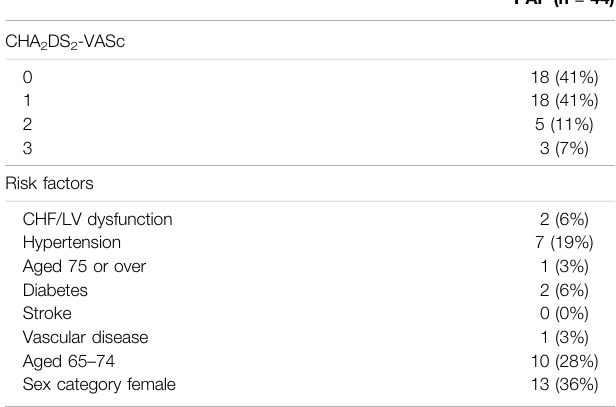
TABLE 2 | Risk score and factors in PAF